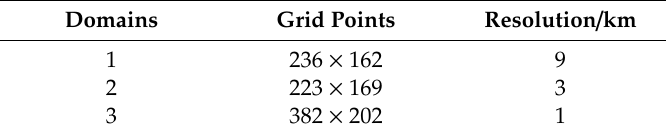
Figure 1. Simulation domains used in the model ( a ) and terrain height ( b ) (shading; Unit: m) of Domain 3 (D03). A: Hongliuhe Station; B: Anxi Station; C: Dunhuang Station; D: Anemometer tower. Table 1. Parameters of nested domain.